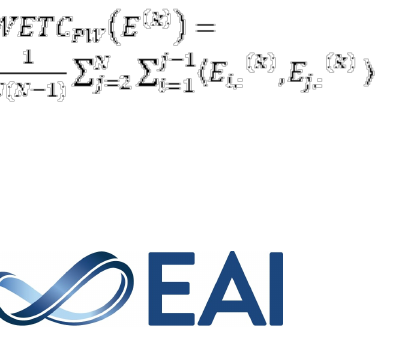
Figure 4. The NPMI of the compared models for the Arabic